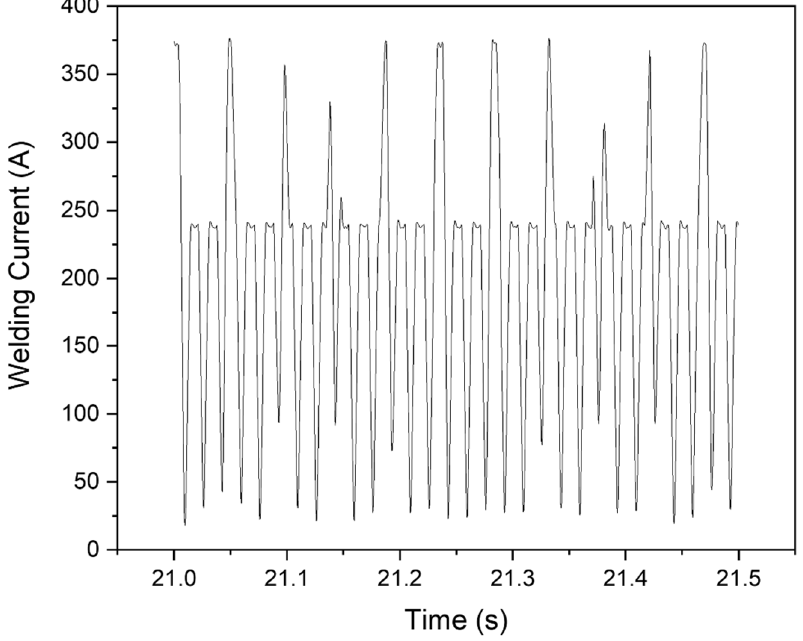
Figure 2. Example of oscillogram displaying pulsed welding current registered over time for cladding 410NiMo stainless steel onto AISI 1020 steel using FCAW at a mean current of 200